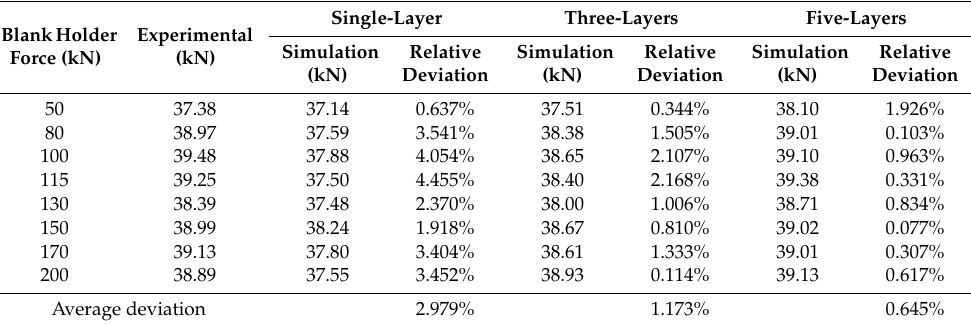
Table 5. Accuracy analysis of the finite element simulation of the maximum forming